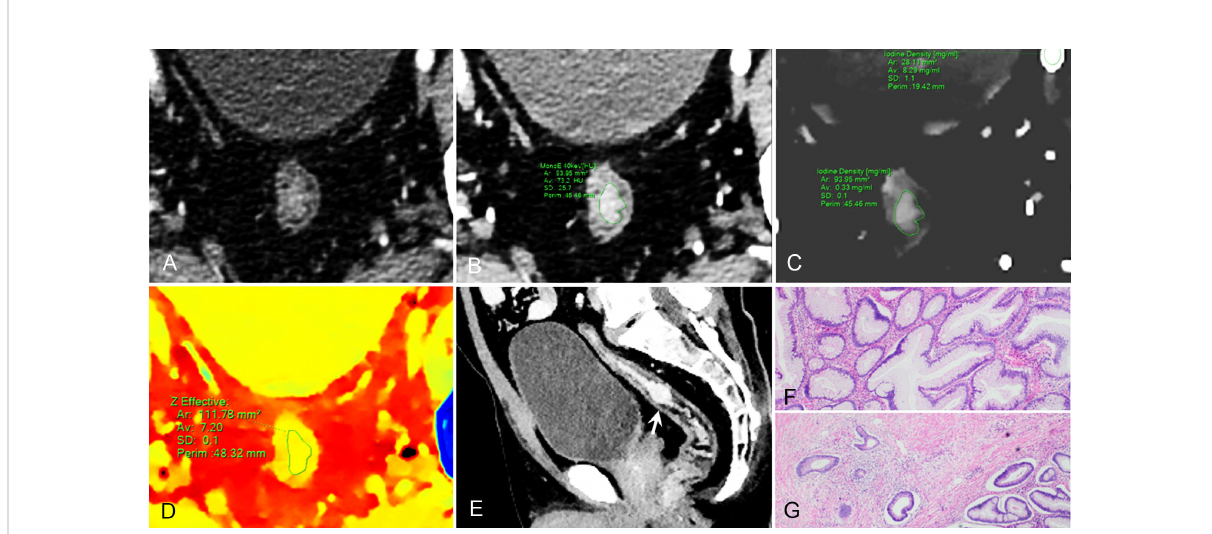
FIGURE 3 59-year-old man with pathological tumor stage 2 and grade 1 rectal adenocarcinoma, who underwent preoperative dual-layer spectral- detector CT. (A) Axial arterial phase (AP) contrast-enhanced image shows irregular wall thickening of the rectum. (B) 40 keV virtual mono- energetic image (VMI) in AP shows apparent contrast enhancement between the lesion and surrounding tissue. (C) Iodine map in AP shows the lesion with an iodine concentration (IC) value of 0.33 mg/ml; the external iliac artery at the same slice with an IC value of 8.29 mg/ml; a normalized iodine concentration(NIC) value of lesion was 0.04 in AP. (D) Effective atomic number (Eff-Z) images in the pre-contrast phase shows the colorful lesion with an Eff-Z value of 7.20. (E) Sagittal reconstruction 40 keV VMI shows the tumor located in upper rectum (arrow). (F) H E staining demonstrates the tumor is mostly composed of gland-forming elements (×40). (G) The tumor cells invade the muscularis propria (×40).